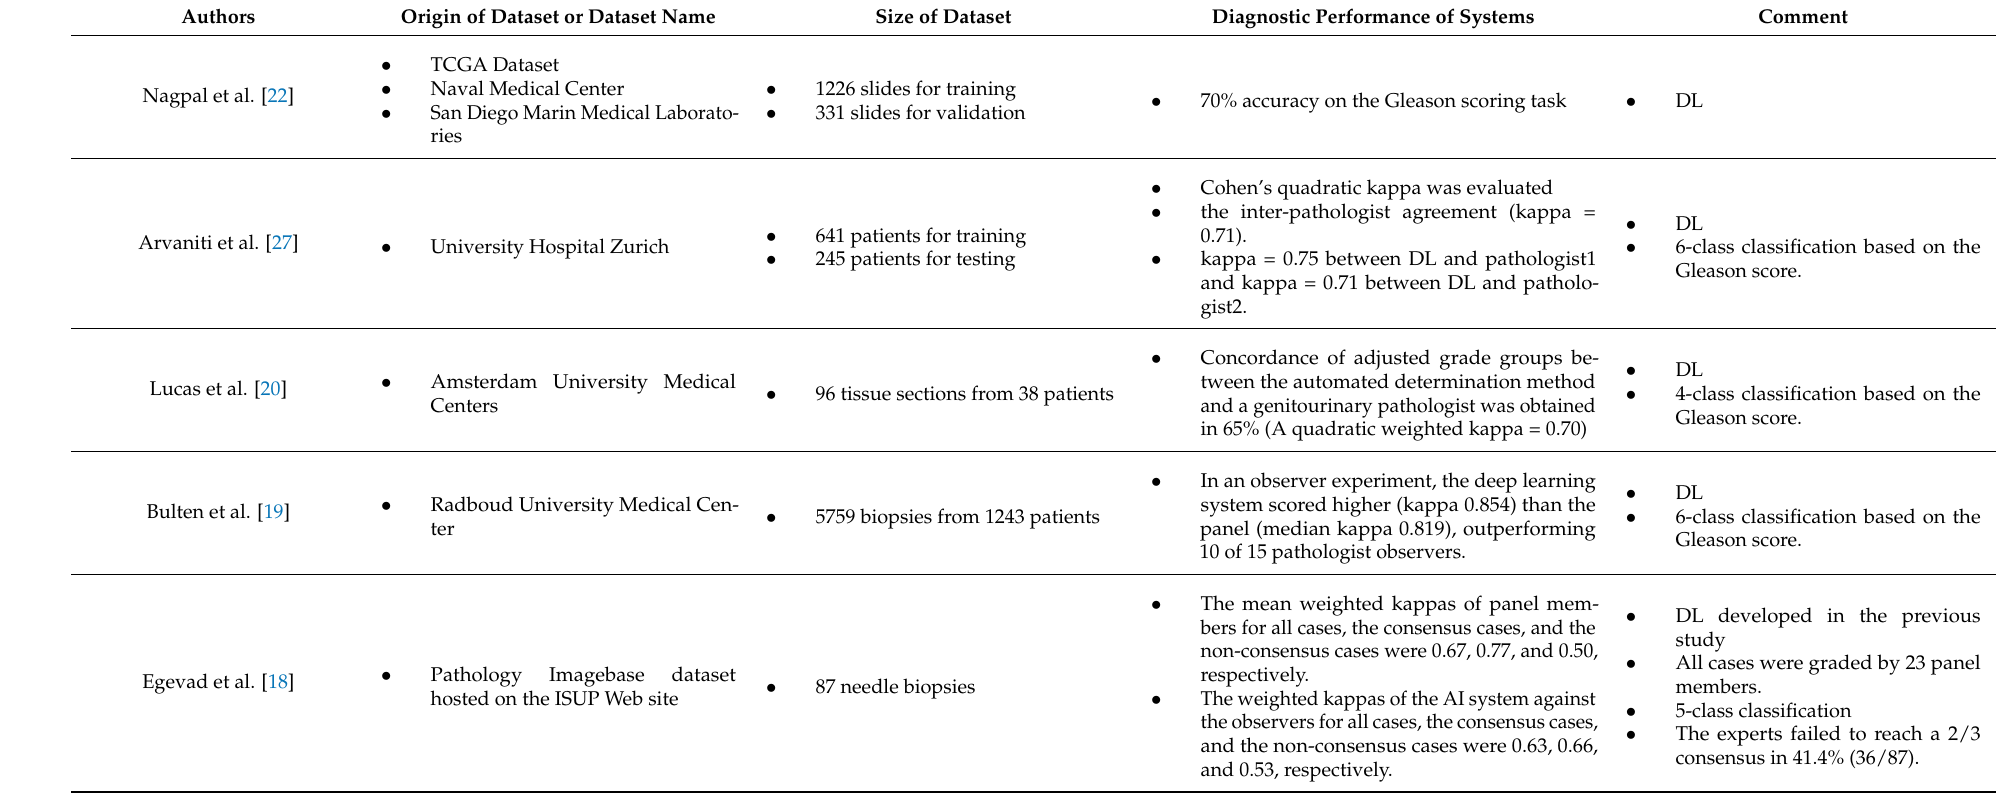
Table 1. Summary of previous studies on the automatic prediction systems of Gleason or ISUP